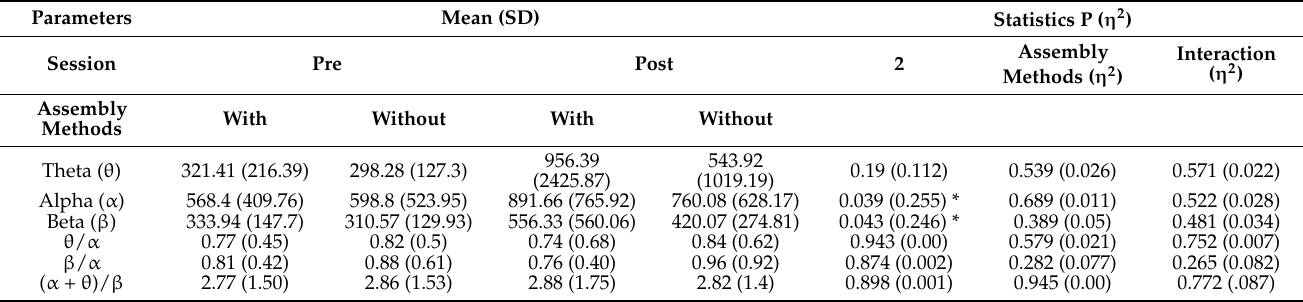
Table 3. Mean (standard deviation) values of relative power of EEG for the theta, alpha, beta rhythms and θ / α , β / α , and ( α + θ )/ β logarithms before and after assembly task with and without pedaling. Parameters Mean (SD) Statistics P ( η 2 ) Session Pre Post 2